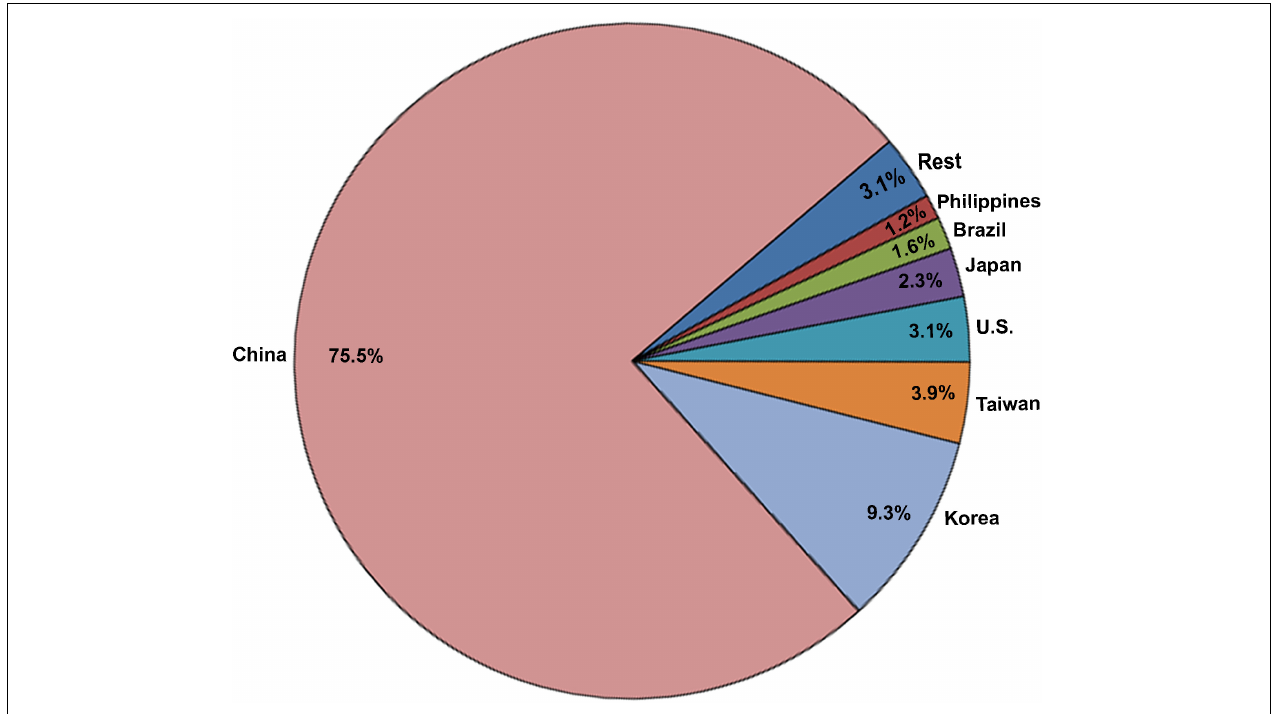
FIGURE 4 | Pie chart showing the geographic distribution of ES-related patents between 2015 and 2020 amongst different countries (Data derived from the Google patent research